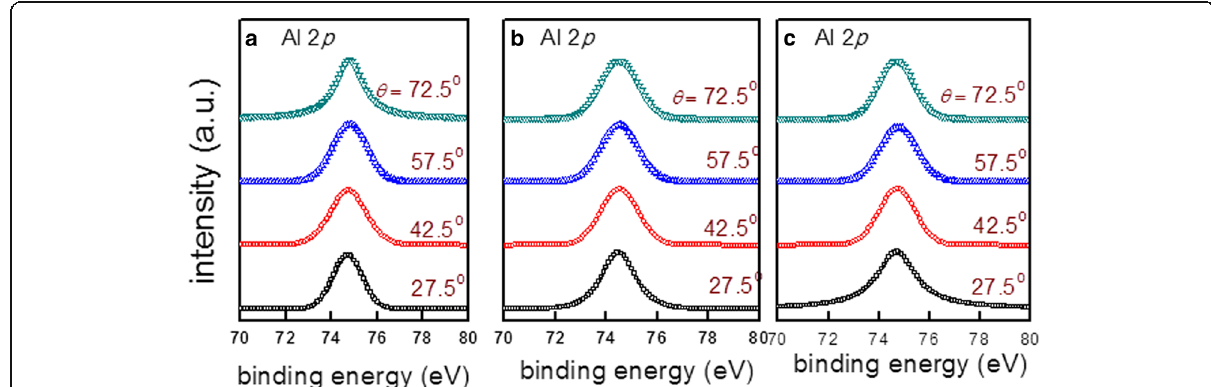
Fig. 3 The XPS Al 2 p core-level spectra for a S1, b S2, and c S3, and the peak indicates the Al – O bond. Moreover, there is no significant BE variation